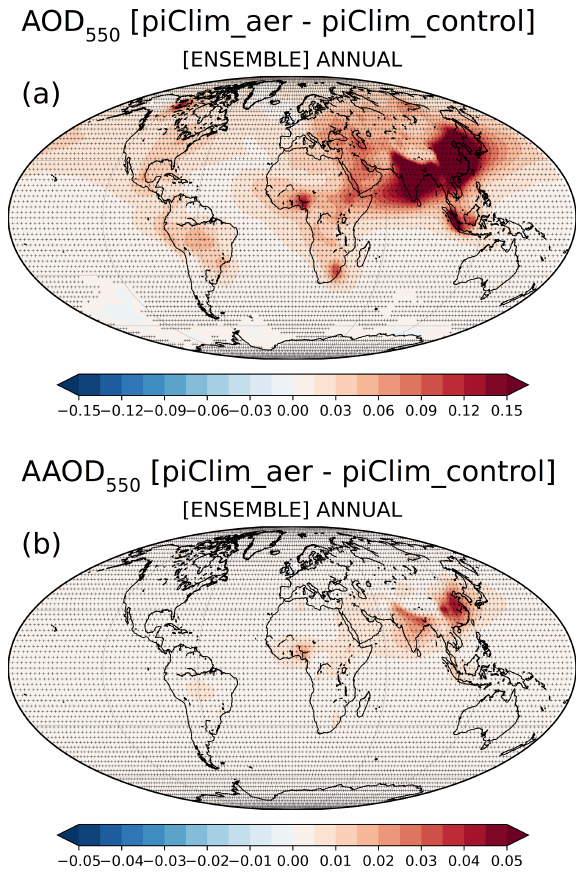
Figure 2. Differences between piClim-aer and piClim-control in (a) AOD at 550nm and (b) AAOD at 550nm for the ensemble of 10 models on an annual basis. The dot shading indicates areas in which the differences are statistically significant at the 95% confi- dence level.